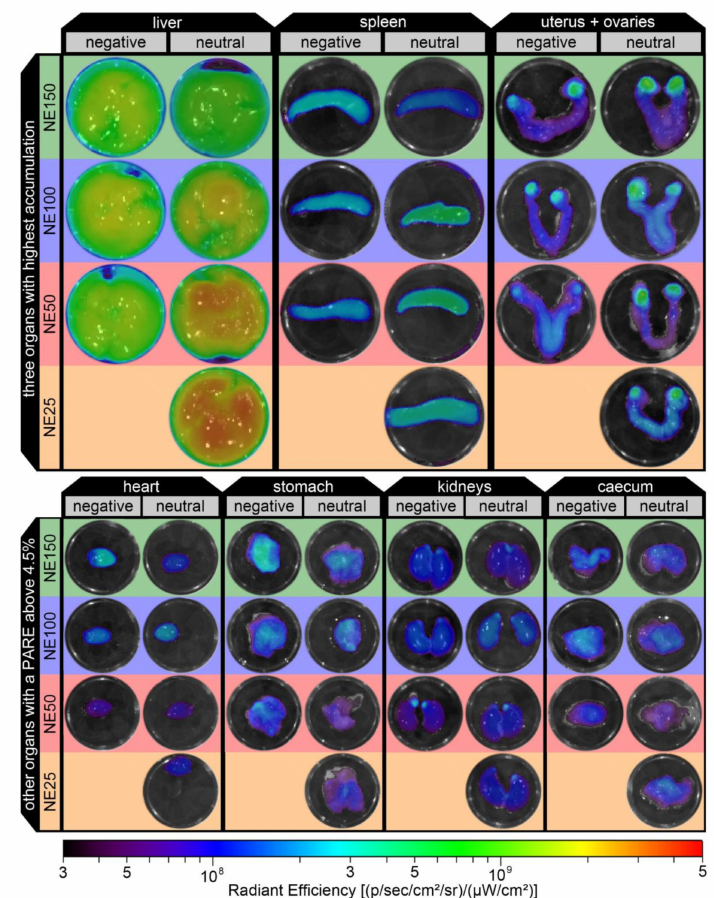
Figure 12. Ex vivo fluorescence images of the excised organs with the highest accumulation (liver, spleen, uterus +ovaries, heart, stomach, kidneys, and caecum) of the representative mice with the three i.v. injected negatively surface-charged nanoemulsions and additionally four previously investigated neutral surface-charged nanoemulsions